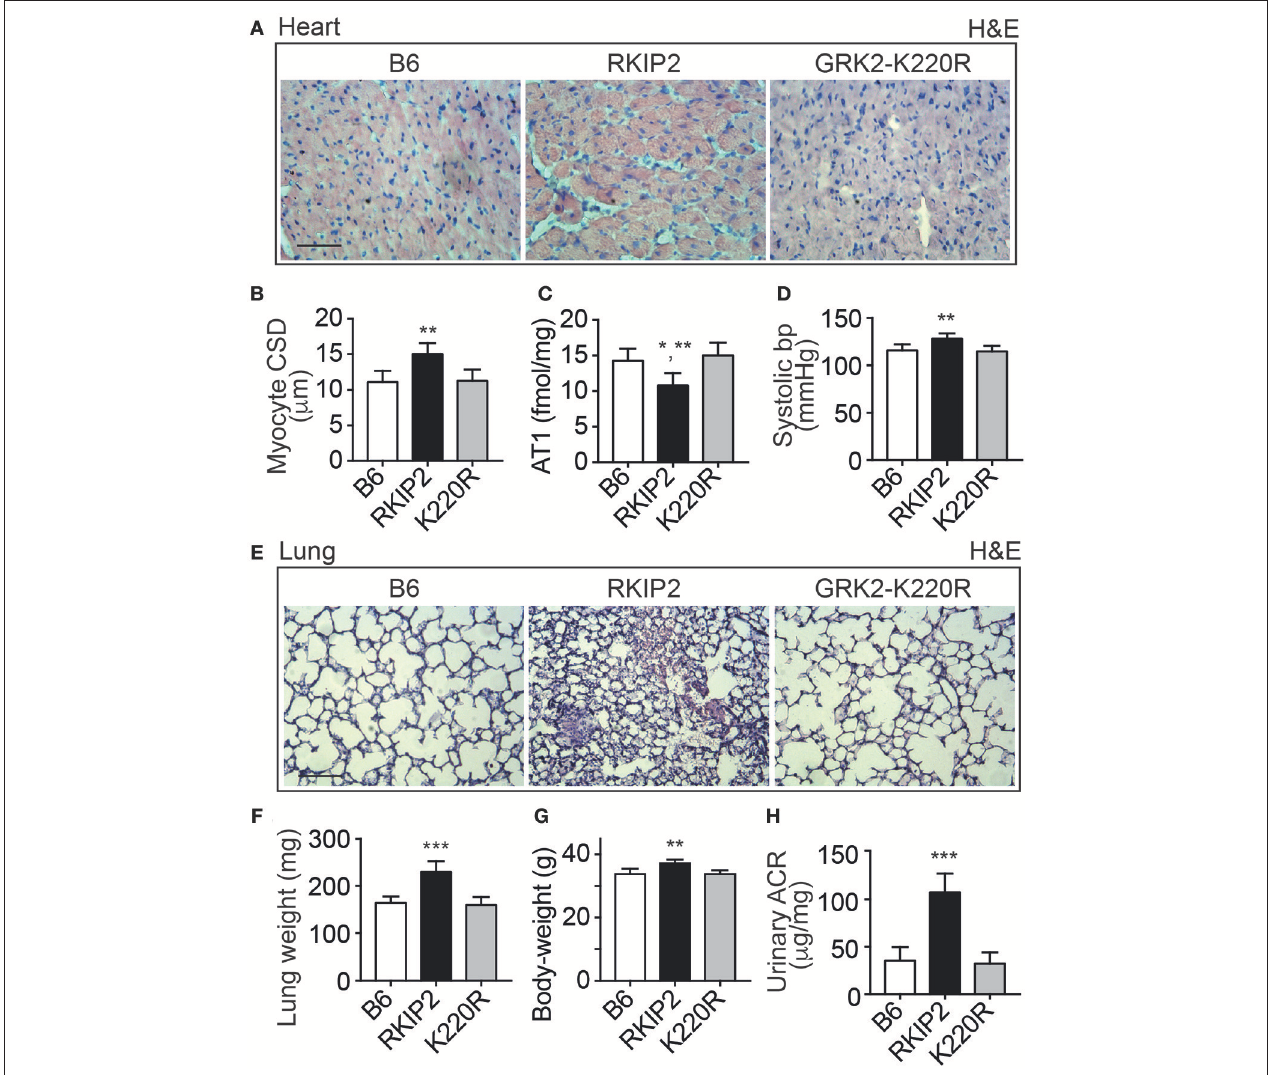
FIGURE 4 | Major symptoms of heart failure with pulmonary congestion and renal dysfunction in Tg-RKIP mice. (A,B) Cardiomyocyte cross-sectional diameter was determined with histological cardiac sections of B6, Tg-RKIP2, and Tg-GRK2K220R mice (A) . (B) Shows quantitative data evaluation. Sections were stained with hematoxylin and eosin (H&E) and are representative of six mice each (bar: 20 µ m). (C,D) Cardiac AT1 receptor content (C) , and systolic blood pressure (D) in B6, Tg-RKIP2 and Tg-GRK2K220R mice. (E) Histological lung sections show heart failure-related lung remodeling with chronic pulmonary congestion and thickening of alveolar septa in Tg-RKIP2 mice compared to healthy non-transgenic B6 and Tg-GRK2K220R mice. Sections were stained with hematoxylin and eosin (H&E) and are representative of six mice each (bar: 40 µ m). (F) Increased lung weight of Tg-RKIP2 compared to B6 and Tg-GRK2K220R mice. (G,H) Increased body weight (G) , and renal insufficiency with proteinuria (H) of Tg-RKIP2 mice compared to non-transgenic B6 and Tg-GRK2K220R mice. Data represent the mean ± s.d. [ n = 6; * p < 0.05 vs. B6; ** p < 0.01 vs. B6 (B,D,G) and K220R (B,C,D,G) ; *** p < 0.001 vs. B6 and K220R; Tukey’s test]. See also Supplementary Figure 4 .